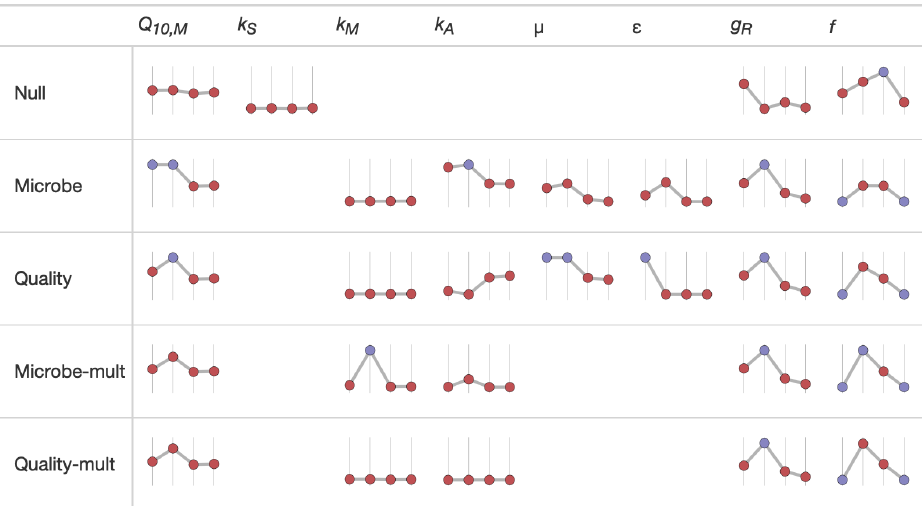
Figure 5. Median values of parameter estimates for different FireResp submodels using the incubation field linear approach at 5cm of depth. The horizontal axis on each sparkline plot is arranged by the year since the burn in the chronosequence (2012, 1990, 1968, or control). In each column the vertical axis scale is the same. Edge-hitting parameters (defined here as within 1 / 10 of a percent of the allowed parameter range) are denoted with the blue coloring.